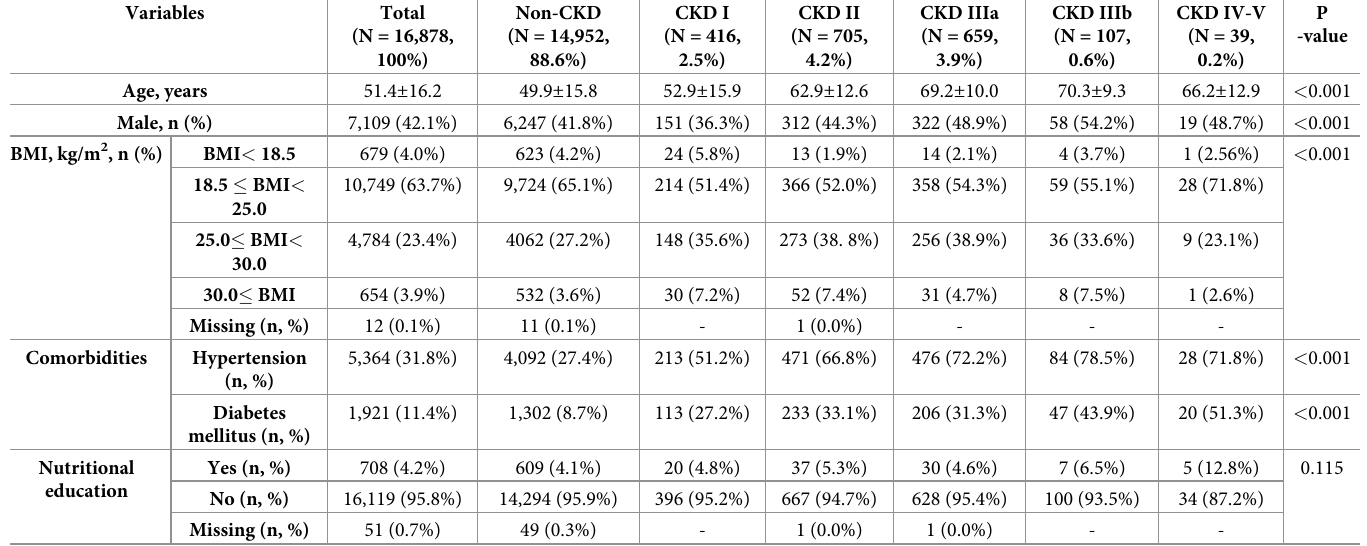
Table 1. Baseline